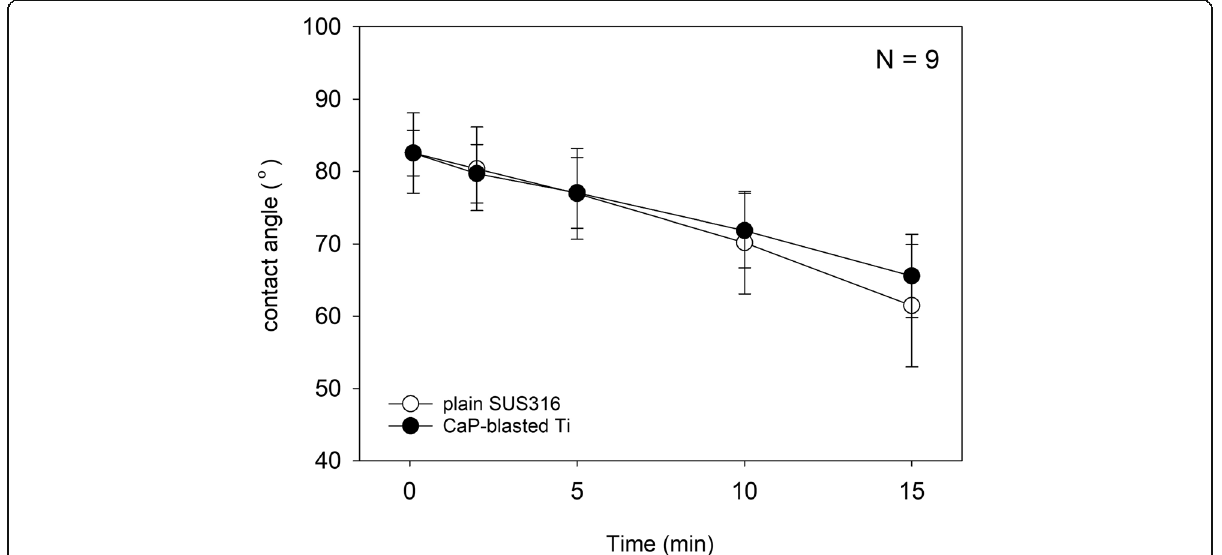
Fig. 2 Time-course changes in contact angles of CaP-blasted cp-Ti and SUS316L surfaces. There was no statistical difference between these surfaces at any of the time points. N =